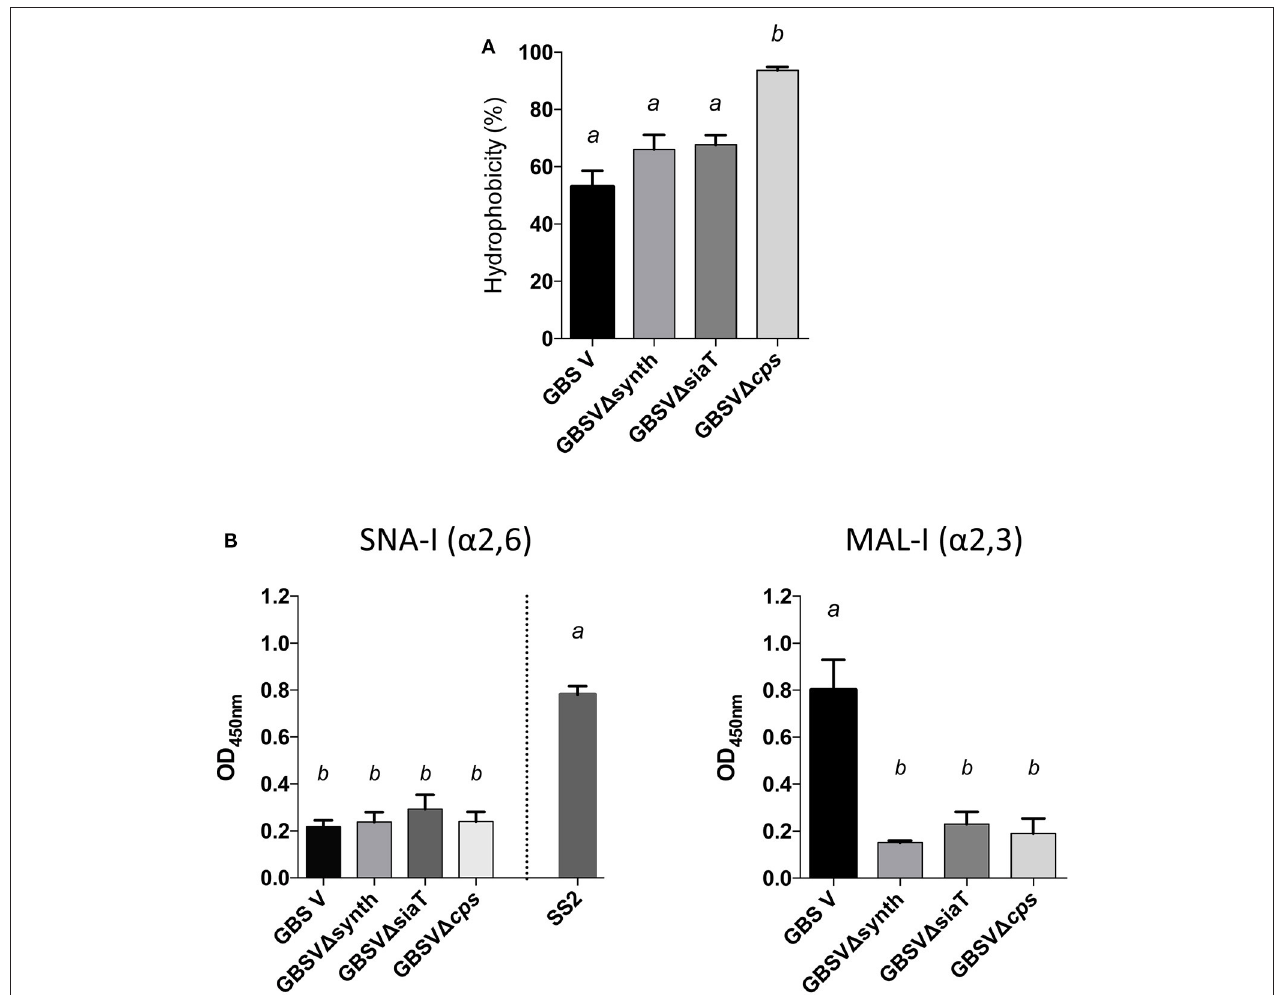
FIGURE 7 | Capsular polysaccharide (CPS) expression levels and recognition of specific CPS sialic acid linkage in GBS type V isogenic mutants. (A) Hydrophobicity (%) of the wild-type GBS serotype V strain (GBS V), and the sialic acid synthesis GBSV 1 synth ( 1 neu5B ) and sialyltransferase GBSV 1 siaT ( 1 cps5K ) deficient mutants. The non-encapsulated strain (GBSV 1 cps ) was used as control. (B) Whole-bacterial cell enzyme-linked lectin assay (ELLA) was performed to detect α -2,3 or α -2,6 capsular sialic acid linkage in these mutant strains. Whole bacteria were incubated with Sambucus nigra agglutinin (SNA-I) specific for Neu5Ac α -2,6 linkages, or Maackia amurensis leukoagglutinin (MAL-I) specific for Neu5Ac α -2,3 linkages. The non-encapsulated mutant GBSV 1 cps was used as negative control. S. suis serotype 2 (SS2) was used as positive control for SNA-I and wild-type GBS type V as positive control for MAL-I. Data in (A,B) are expressed as mean ± SEM of at least three independent experiments. Student’s t -test analyses reported significant differences between “ a” and “ b” ( P <